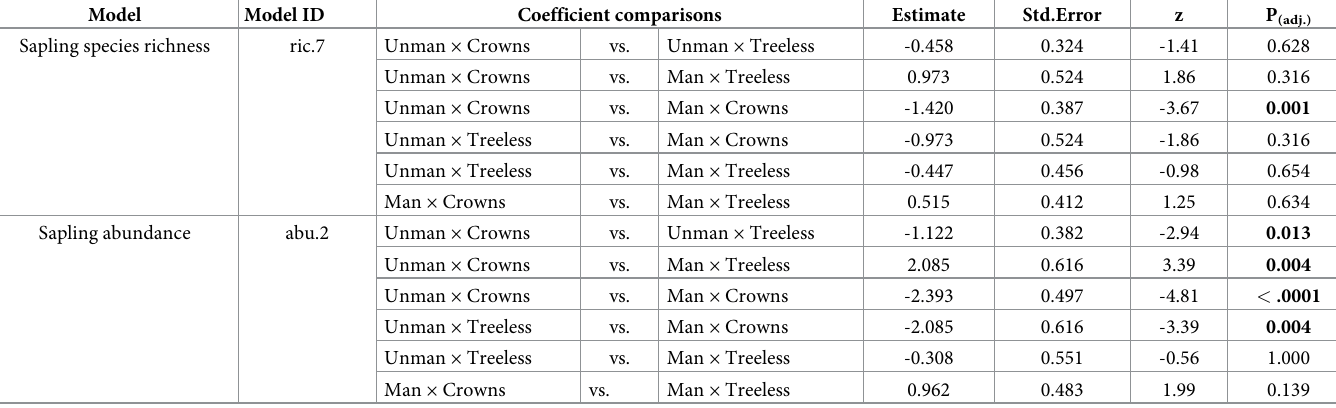
Table 2. Comparisons among groups of land management and araucaria crown influence of selected models for evaluating saplings species richness and abundance in an upper-montane Araucaria forest, southern Brazil. These results are represented in Figs 1 and 2.